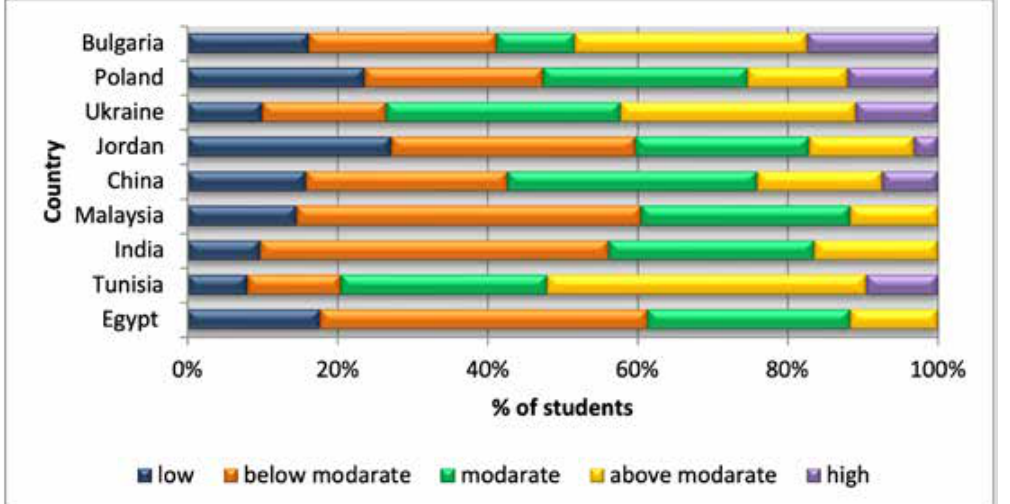
Figure 3. Distribution by levels of speed and strength training of